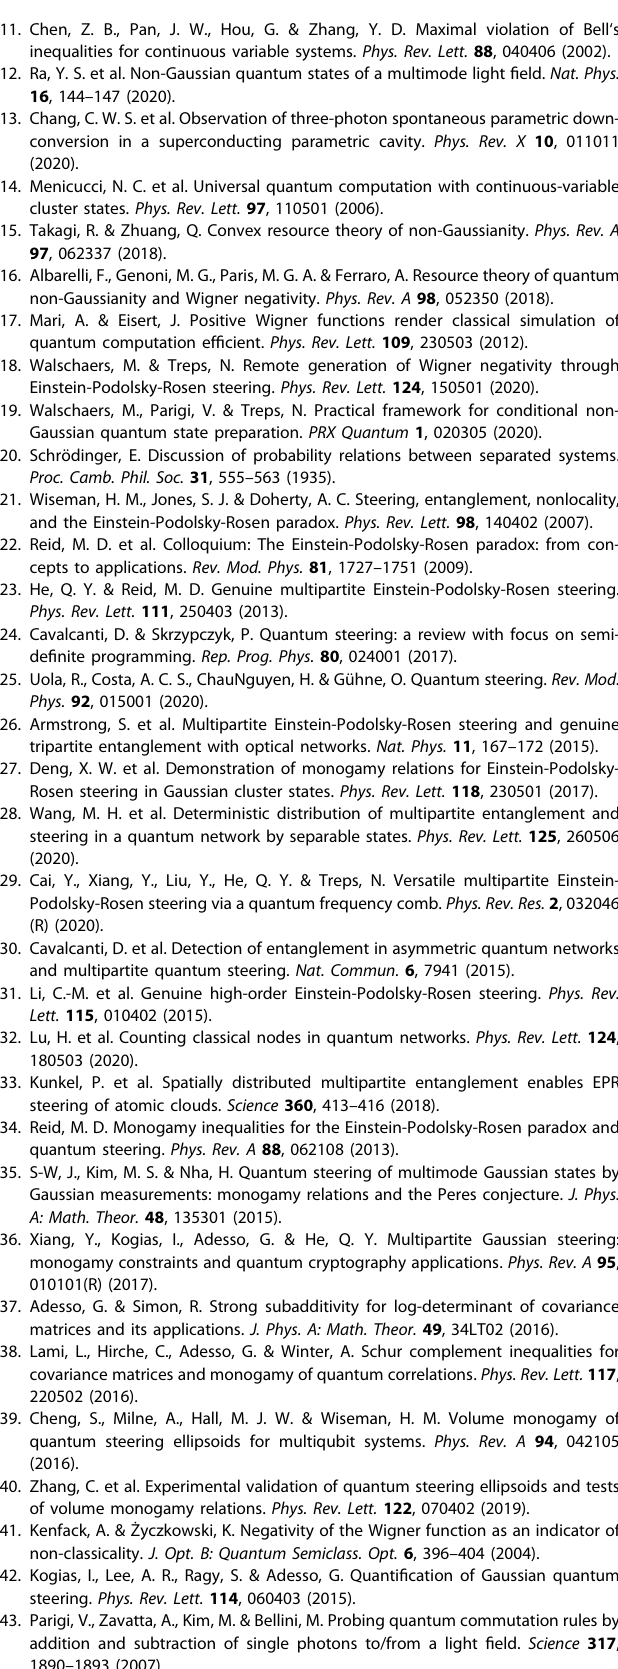
Fig. 6c. This settles an open question for the shareability of generated Wigner negativity in this direction. DATA AVAILABILITY